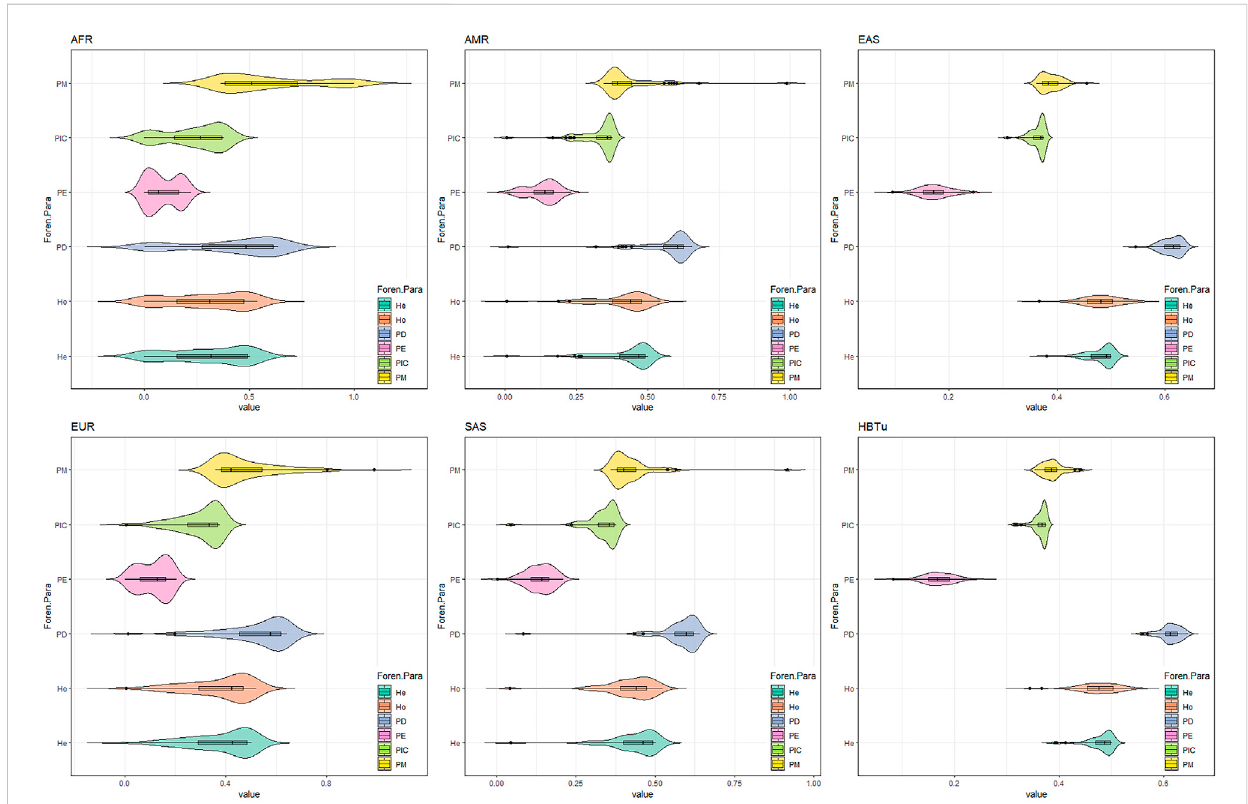
FIGURE 3 Forensic parameters (PM, PIC, PE, PD, Ho, and He) comparisons of 57 InDels between the studied Tujia (HBTu) group and fi ve intercontinental